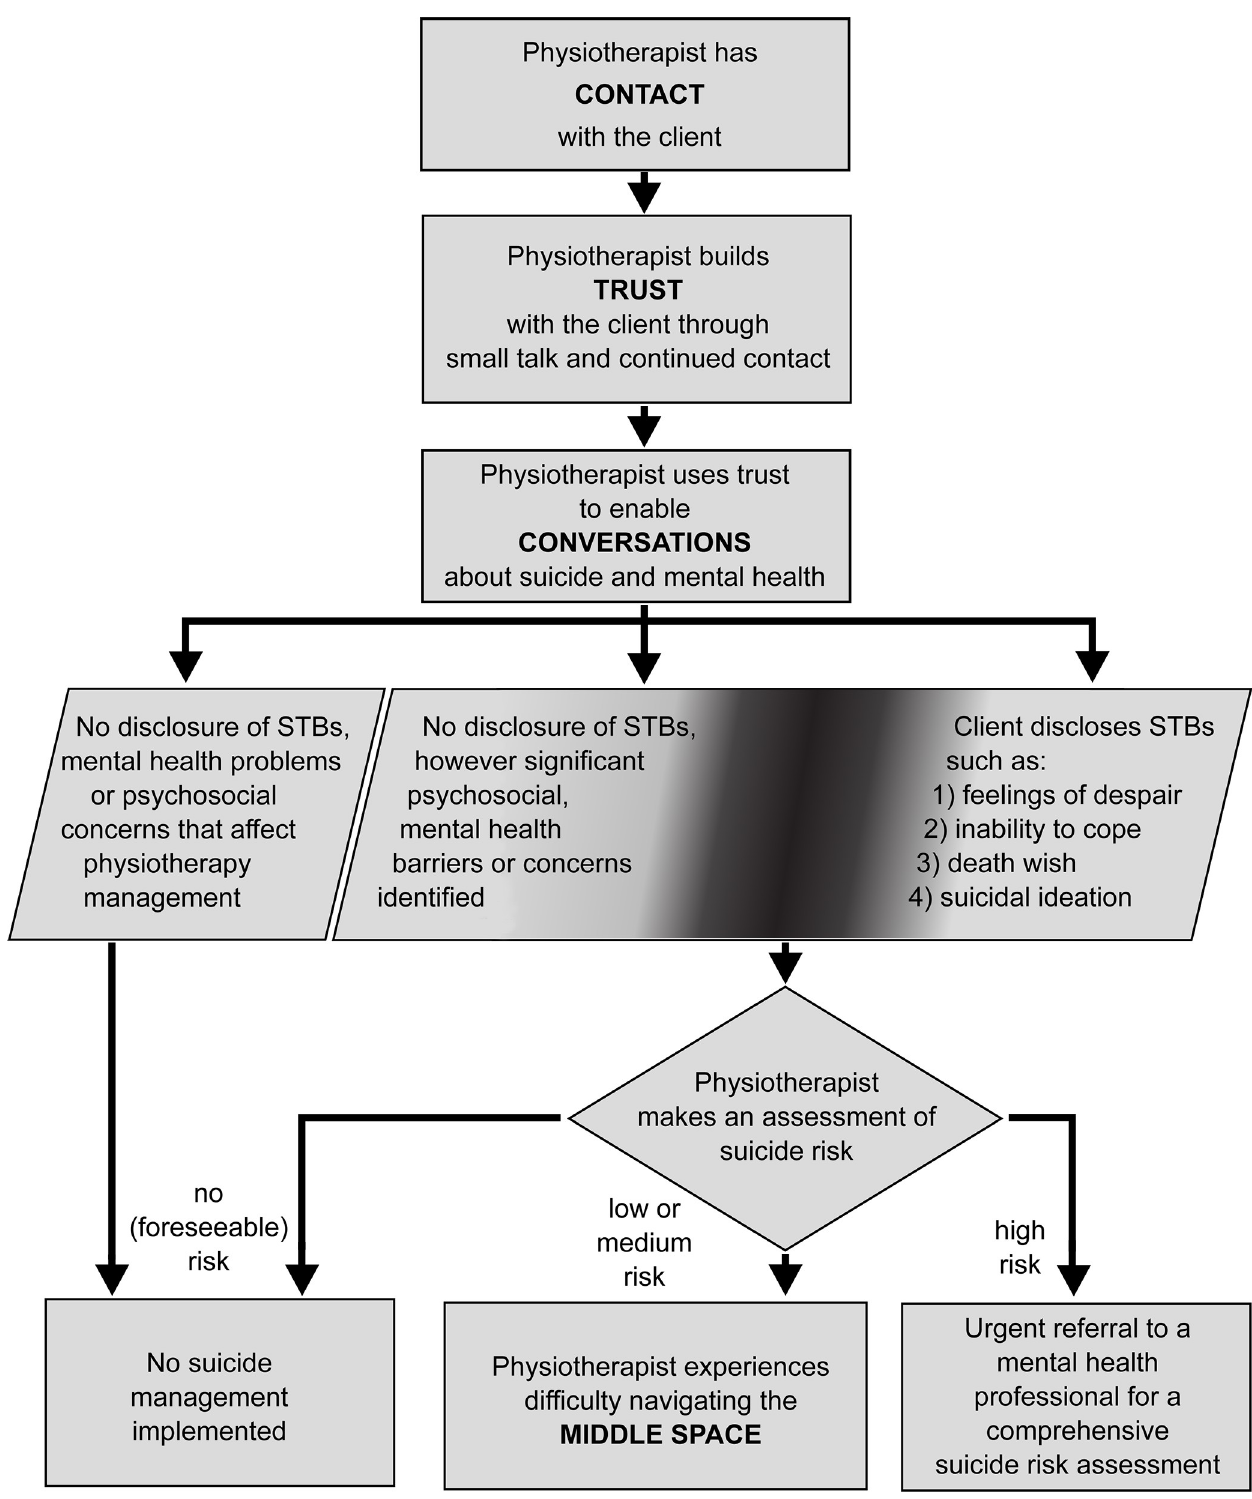
Fig 3. Overview of the relationship between the key themes.